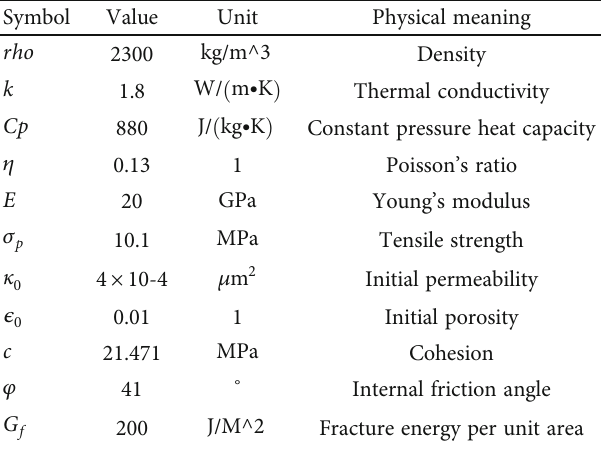
Table 1: Physical parameters of the